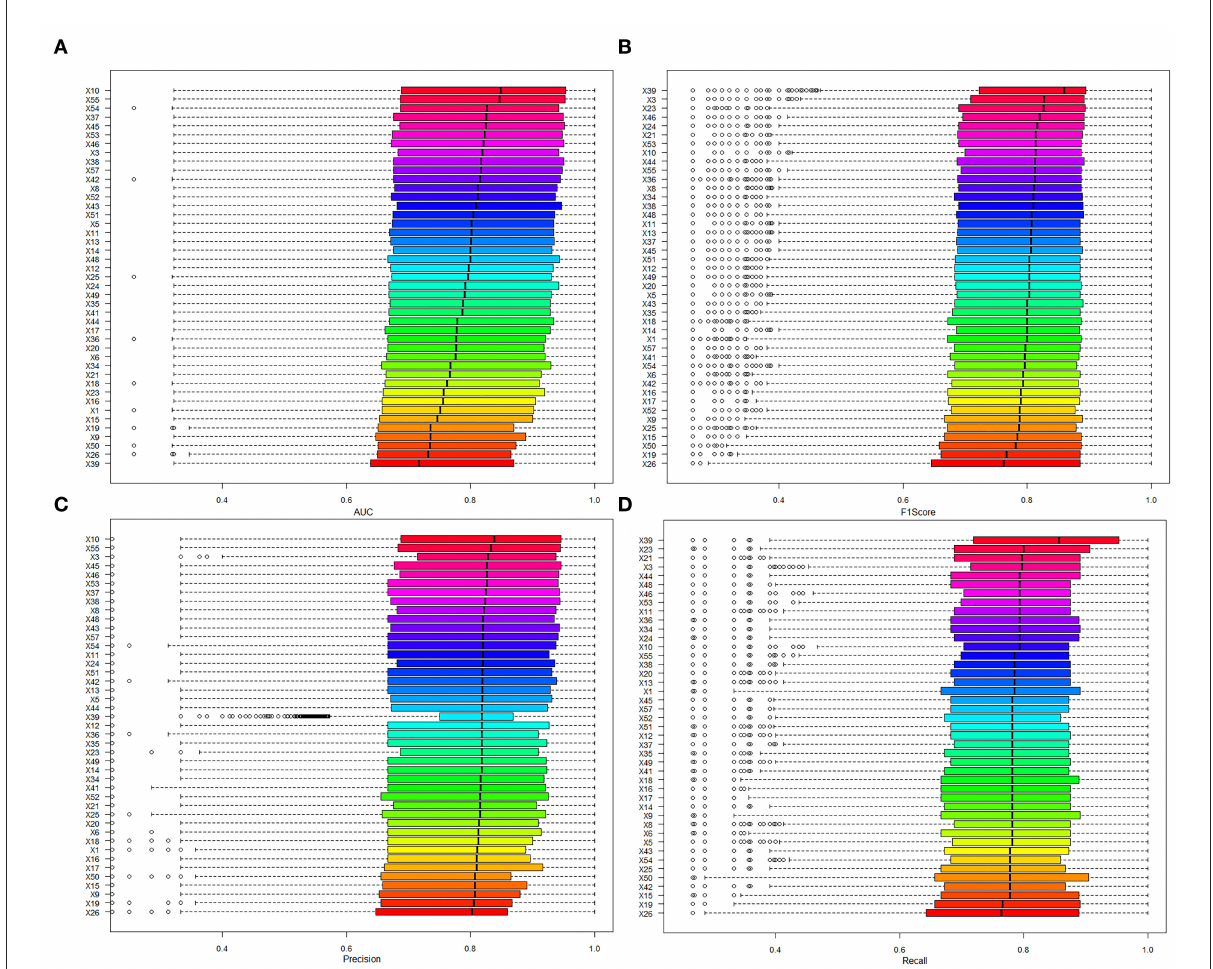
FIGURE4 The model performance of models when the variables were included. (A) The results of AUC. (B) The results of the F1 score. (C) The results of precision. (D) The results of